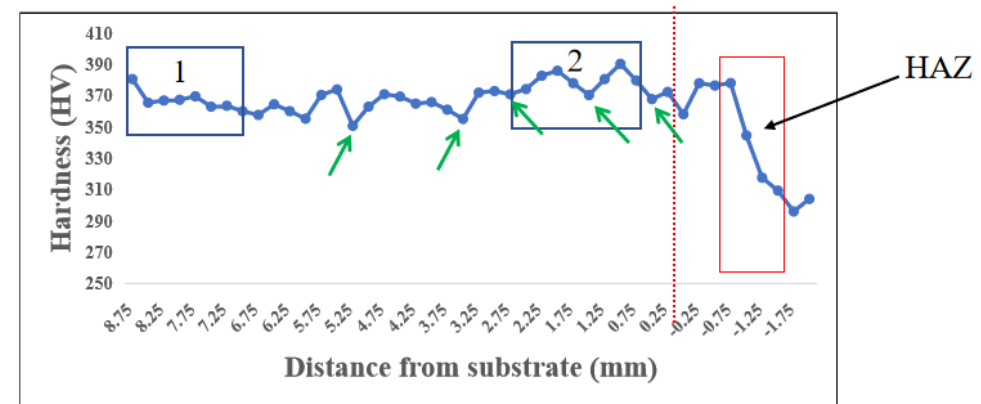
Figure 9. Microhardness of the cross-section of a thin-wall sample.